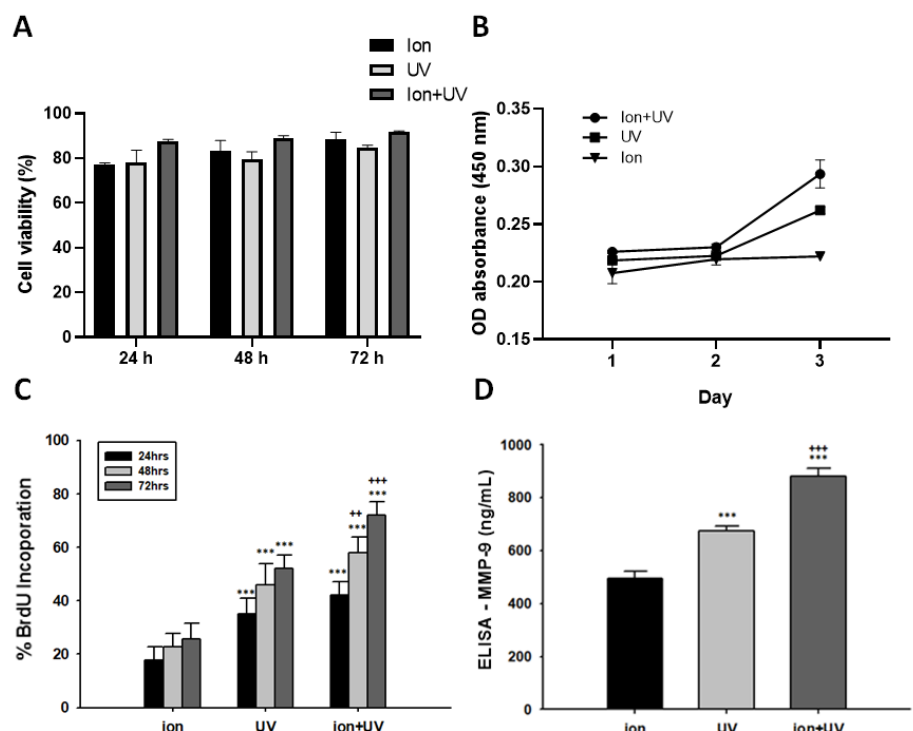
Figure 5. Cell viability analysis. ( A ) Cell viability assay of 3D-encapsulated hMSCs in hydrogel ( n = 3). Cells under ion + UV condition shows better viability than other conditions. ( B ) CCK-8 cell proliferation assay ( n = 3). The OD absorbance was measured at 450 nm. ( C ) Under ion + UV condition, compared other conditions, the BrdU incorporation were significantly higher values ( n = 3). Data were expressed as mean ± S.D. *** indicates p < 0.001 vs. ion, ++ p < 0.01, and +++ p < 0.001 vs. UV). ( D ) ELISA assay of MMP-9. The expression level of MMP-9 was highest under ion + UV condition, followed by UV condition, and lowest under ion condition ( n = 3) (data were expressed